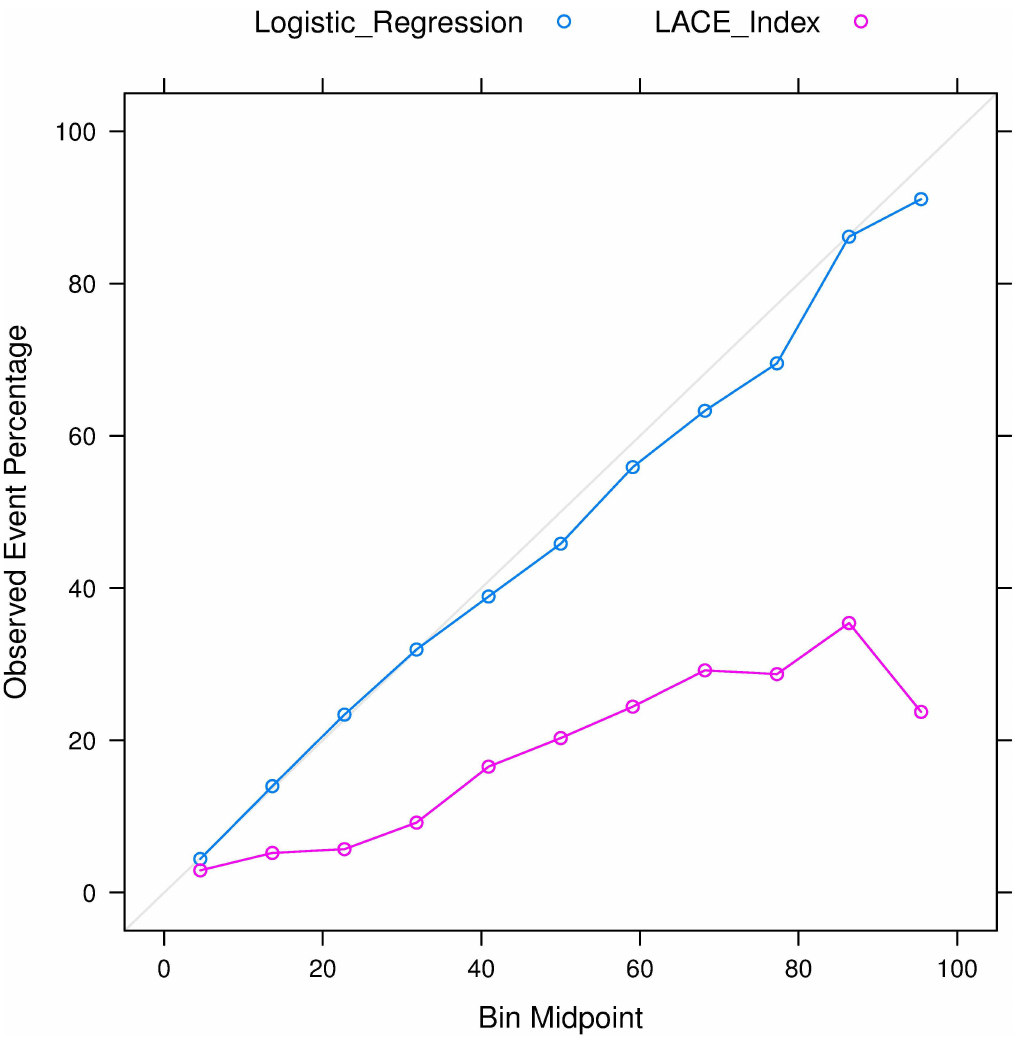
Fig 3. Comparison of the calibration plots between our logistic regression model and the LACE index. The calibrationcurves were generatedusing “caret” packagein R version 3.2.3 (R Foundation, Vienna, Austria).